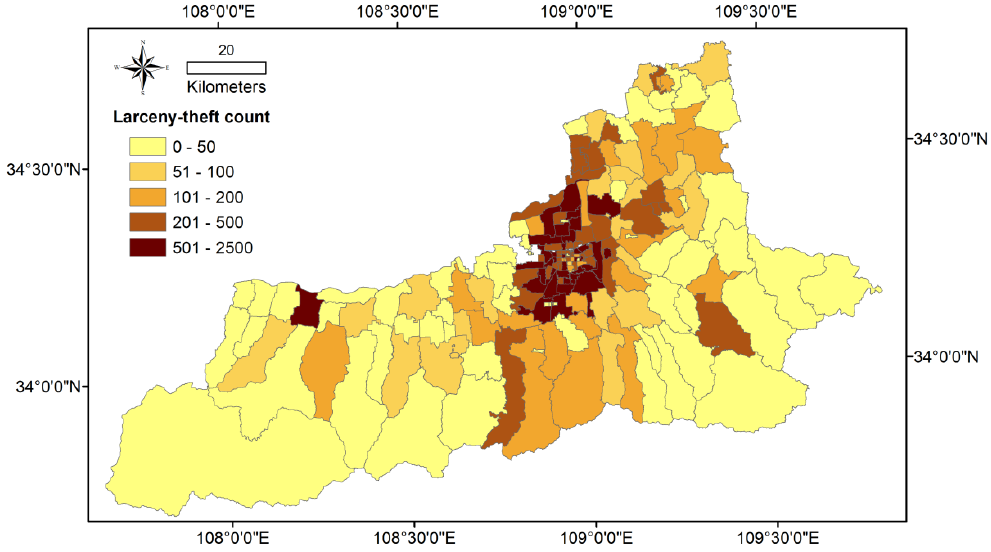
Figure 2. Spatial distribution of larceny-theft in Xi’an, China.